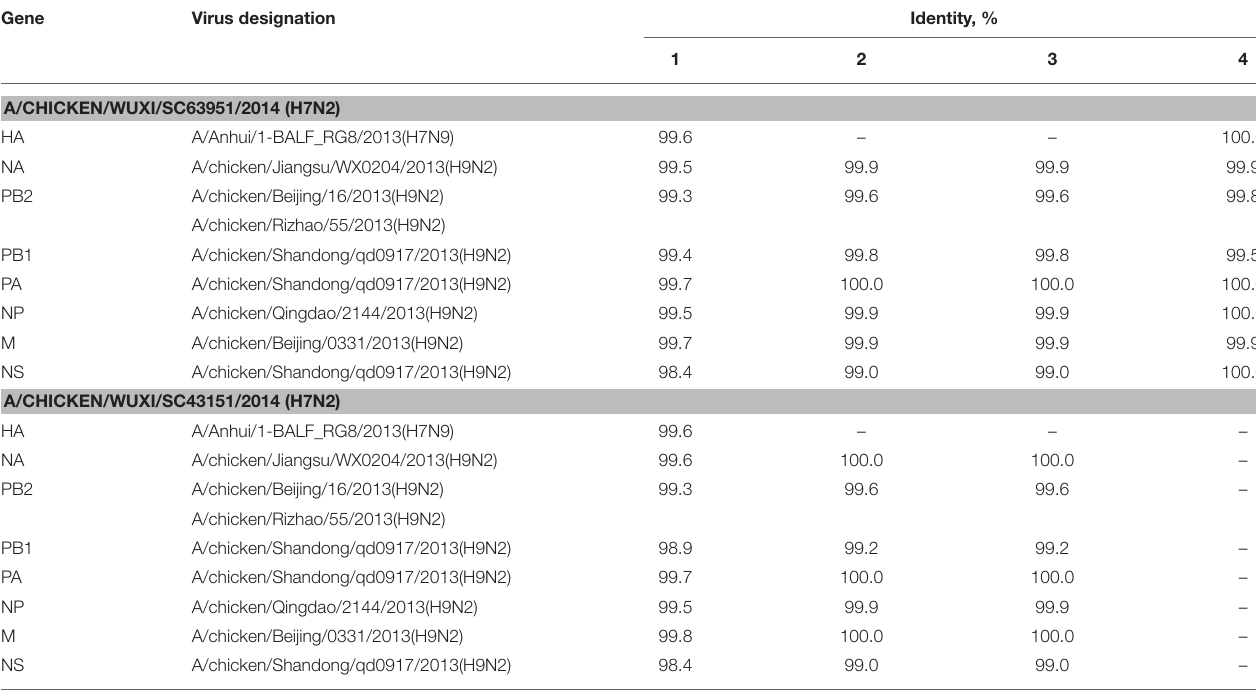
TABLE 1 | Influenza A viruses with greatest nucleotide sequence identity to avian influenza A (H7N2) viruses and sequence comparison of isolated in present study from Wuxi, China, 2014. Gene Virus designation